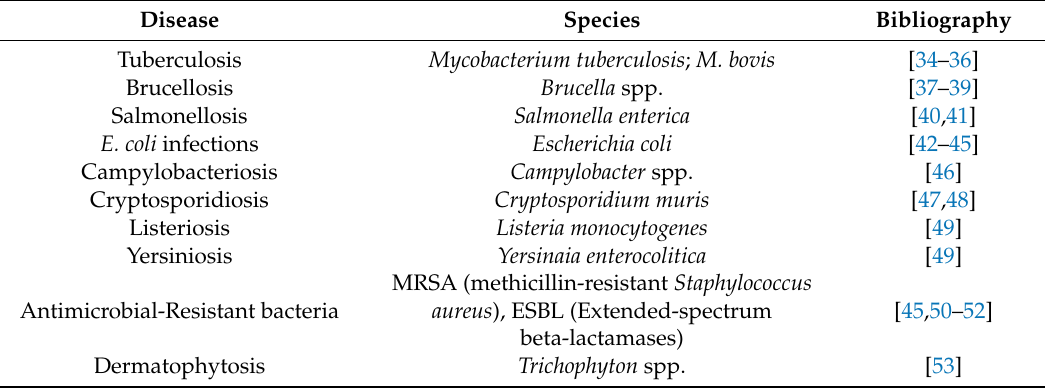
Table A7. List of relevant zoonosis in gira ff e and in other animals reported in zoo human–animal interactions included in Phase